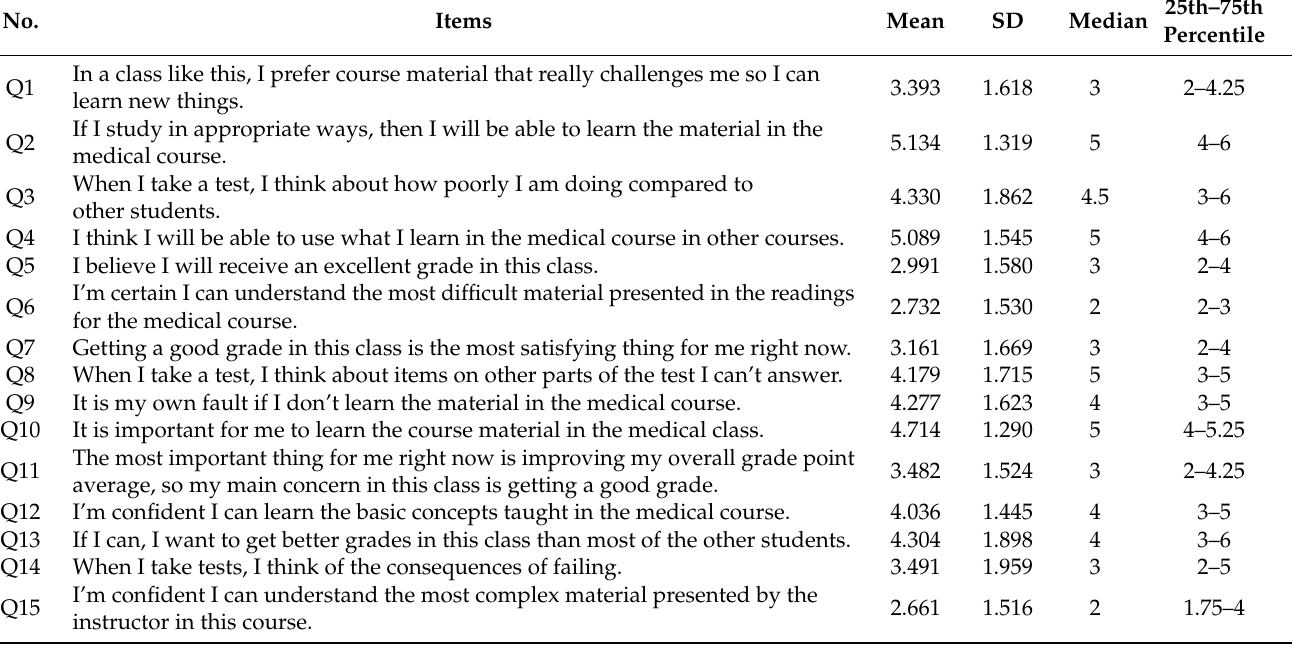
Table 1. Descriptive statistics of the Motivation